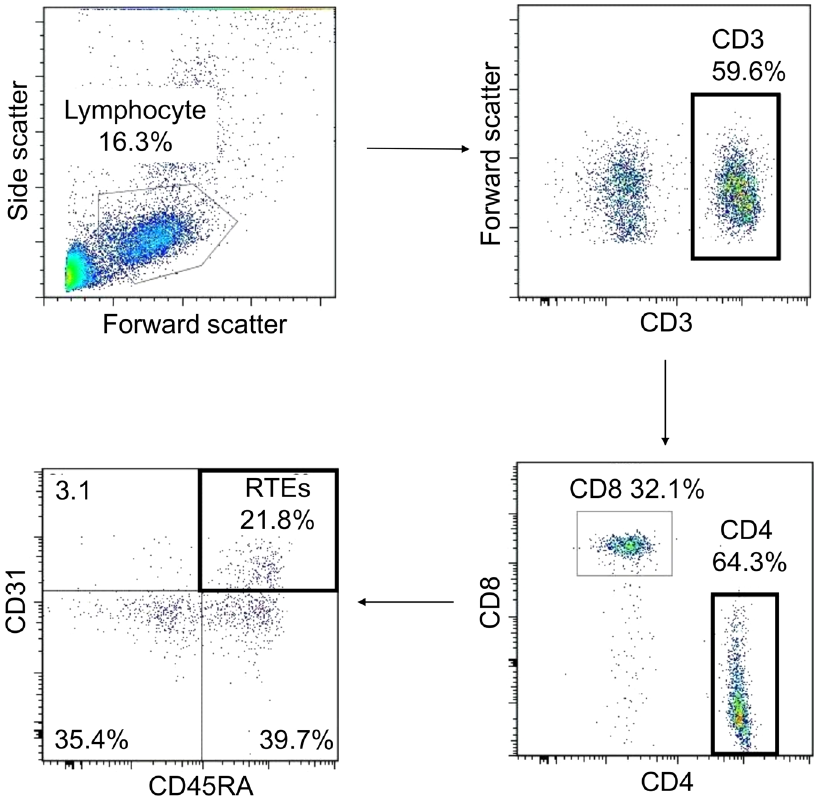
Figure 2. Representative data from flow cytometric detection of CD3 + CD4 + CD45RA + CD31 + cells (recent thymic emigrants,